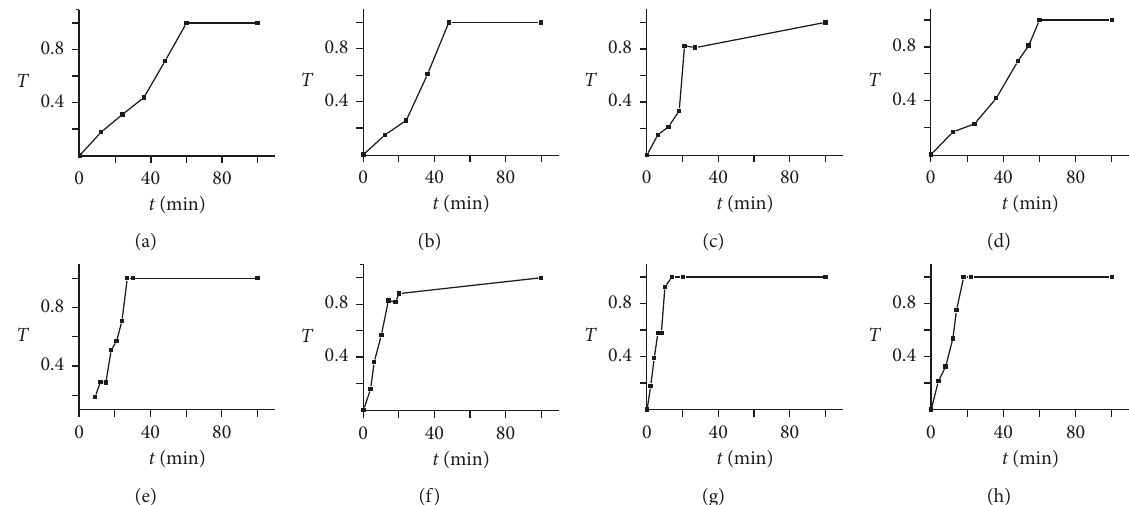
Figure 3: Change of XRD characteristic T value of 8 batches of calamine samples during calcination. (a) S1. (b) S2. (c) S3. (d) S4. (e) S5. (f) S6. (g) S7. (h)